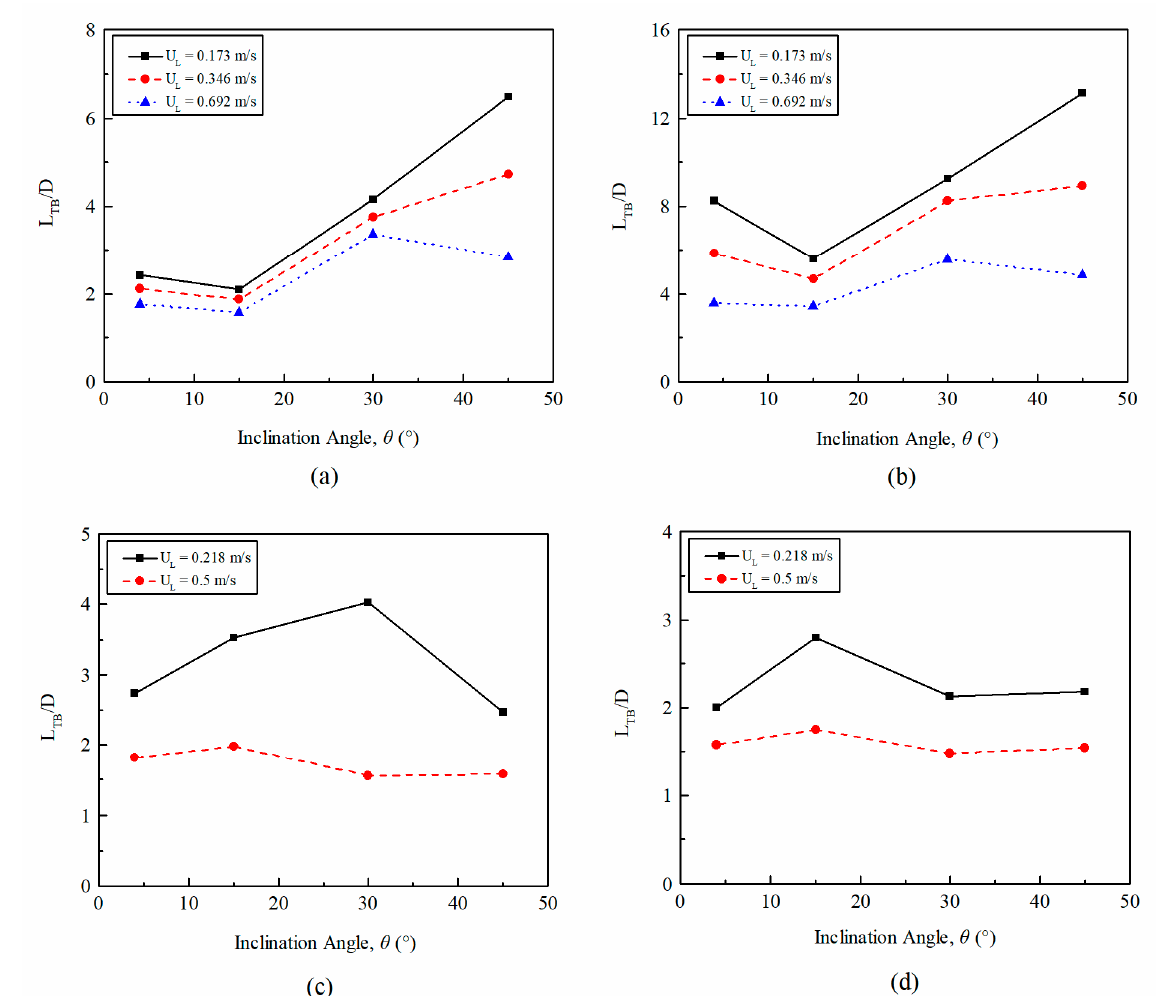
Figure 19. Dimensionless bubble length ( L TB / D ) as a function of θ . ( a ) Water volume 1; ( b ) water volume 2; ( c ) 45 lb/bbl BW; ( d ) 48.5 lb/bbl BW.